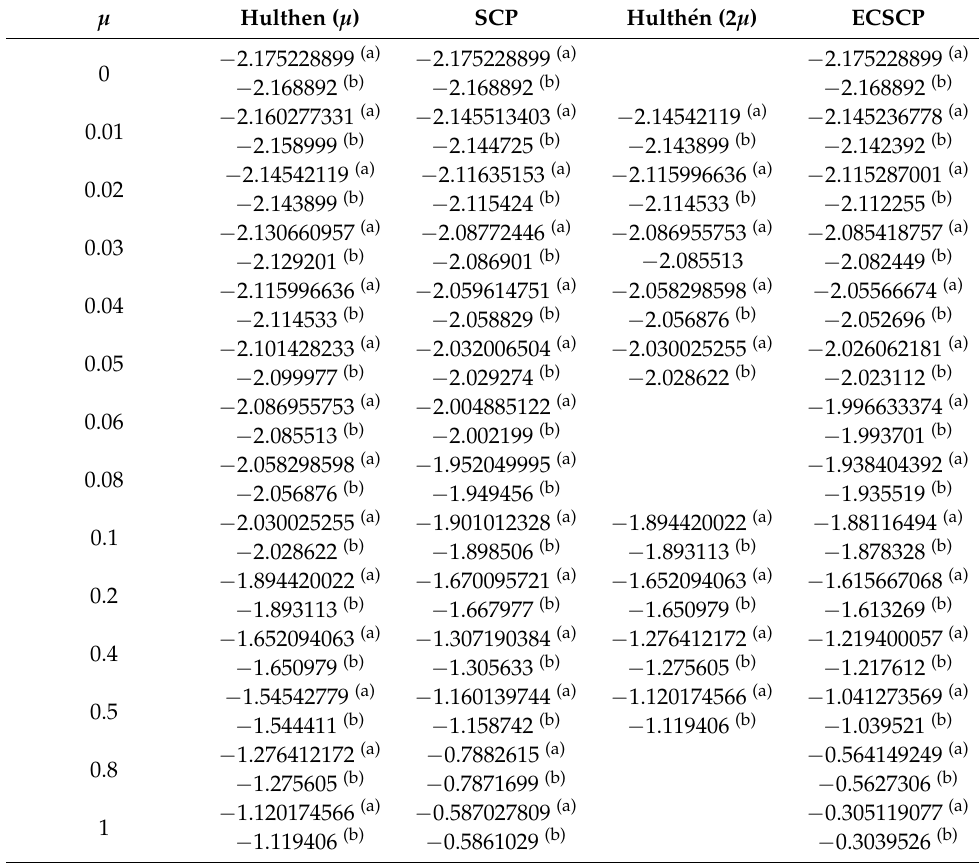
Table 6. Comparison between (a) LMM and (b) VMC for (1s2s) excited states of 3 S energies of